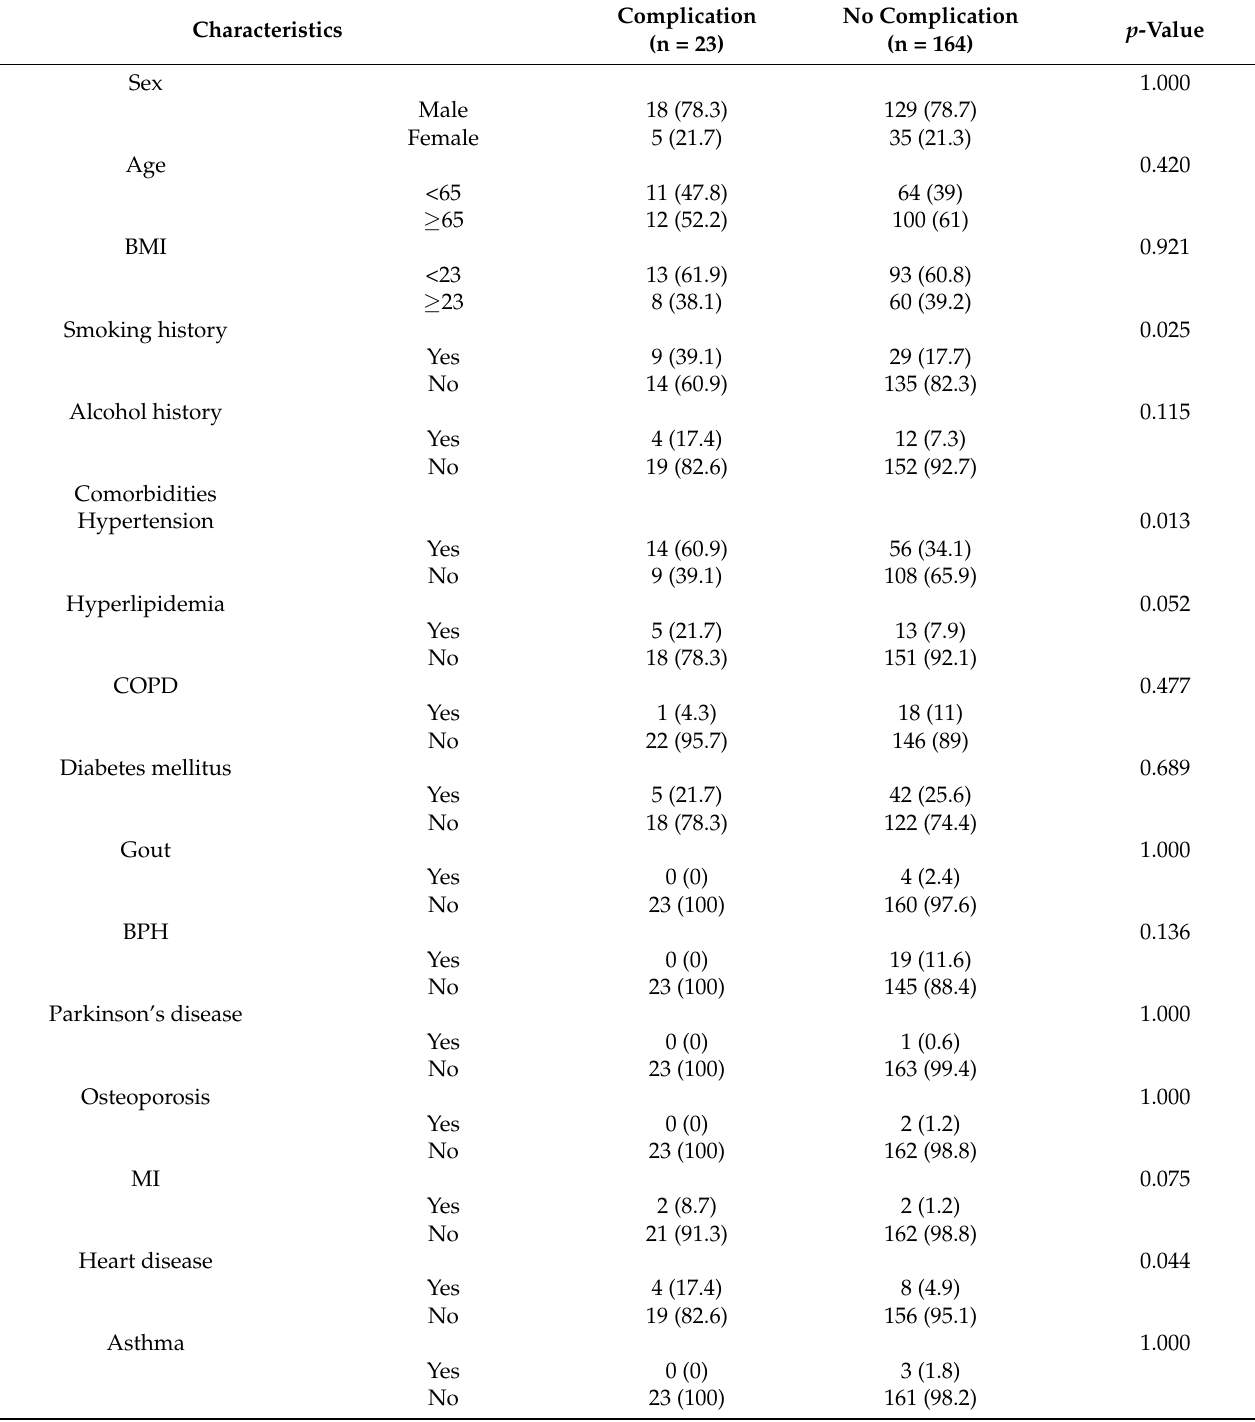
Table 1. Factors associated with thyroid-related adverse events in patients receiving immune checkpoint inhibitors.